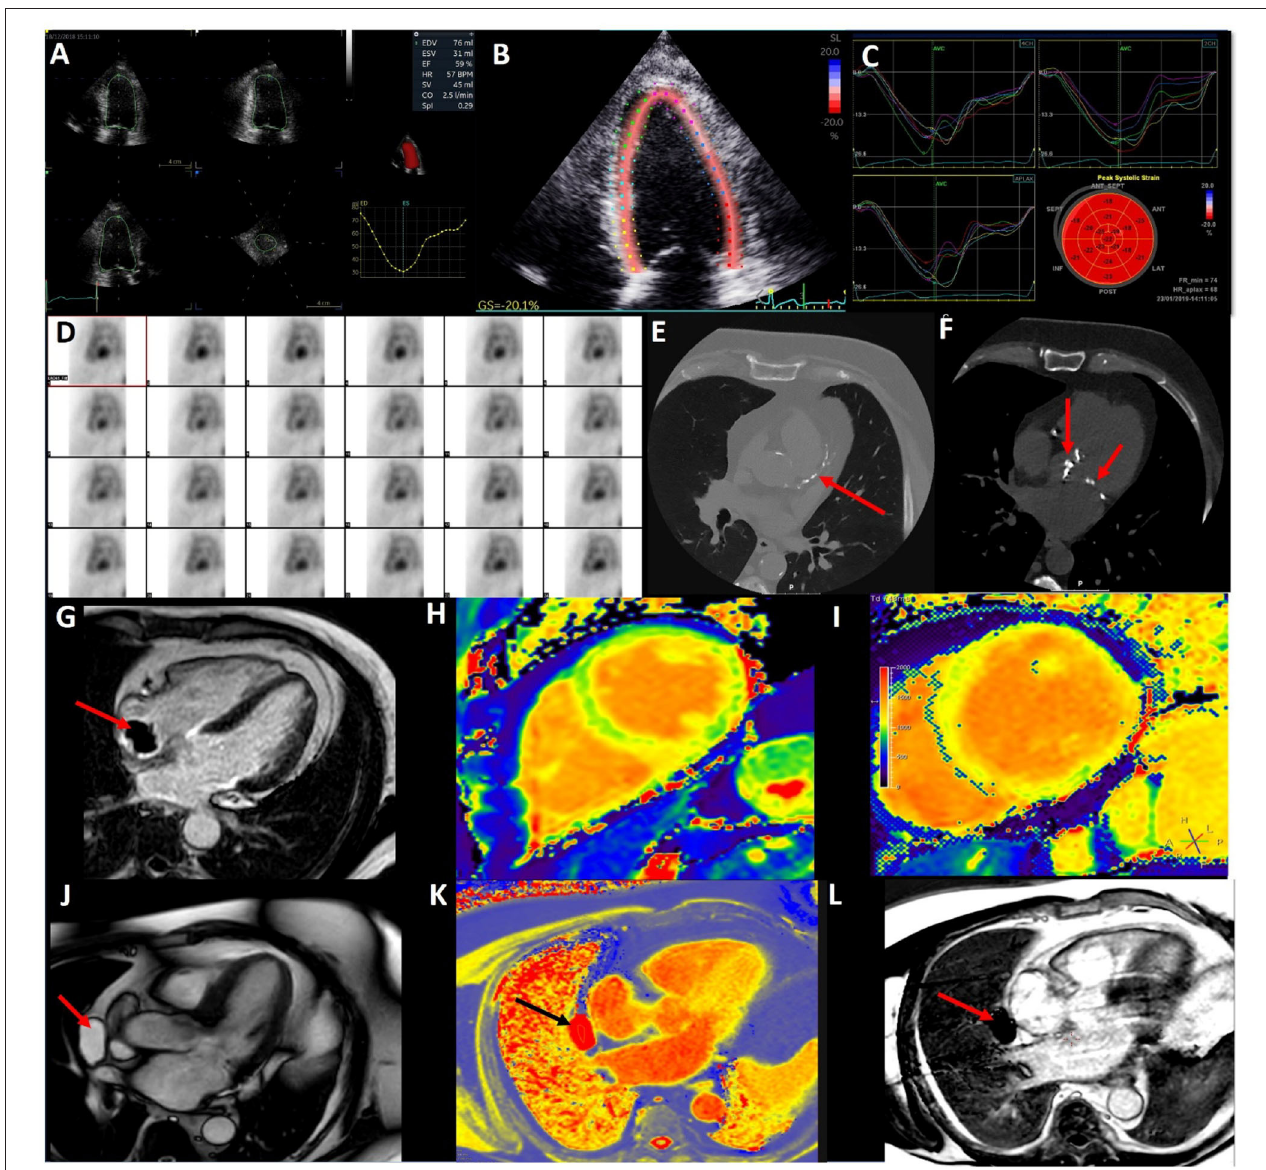
FIGURE 1 | Multi-modal imaging in cardio-oncology. (A) 3D echocardiography to accurately calculate left ventricular volumes and ejection fraction. (B) 2D Speckle Tracking Echocardiography of the left ventricle (4 chamber view) for Global Longitudinal Strain. (C) 2D Left Ventricular Global Longitudinal Strain curves from 4, 2, and 3 chamber views. (D) Nuclear medicine—Multi-gated blood pool imaging to determine LVEF. (E) CT coronary angiogram demonstrating coronary artery calcium in the left anterior descending artery in a lymphoma survivor. (F) CT coronary angiogram demonstrating radiotherapy related aortic and mitral valve calcification in the same patient. (G) Cardiac Magnetic Resonance (CMR) late gadolinium enhancement with long T1 inversion time demonstrating a thrombus (red arrow) on the end of a Hickman’s line in a cancer patient. (H) Normal CMR T1 map (green is normal myocardium). (I) T1 map showed elevated T1 times of the left ventricle in myocarditis. (J) CMR 3Ch cine demonstrating a pericardial mass (red arrow). (K) CMR T1 map highlight the pericardial mass is fill with fluid (black arrow). (L) CMR LGE with long T1 inversion time demonstrating mass (red arrow) is avascular with no enhancement.